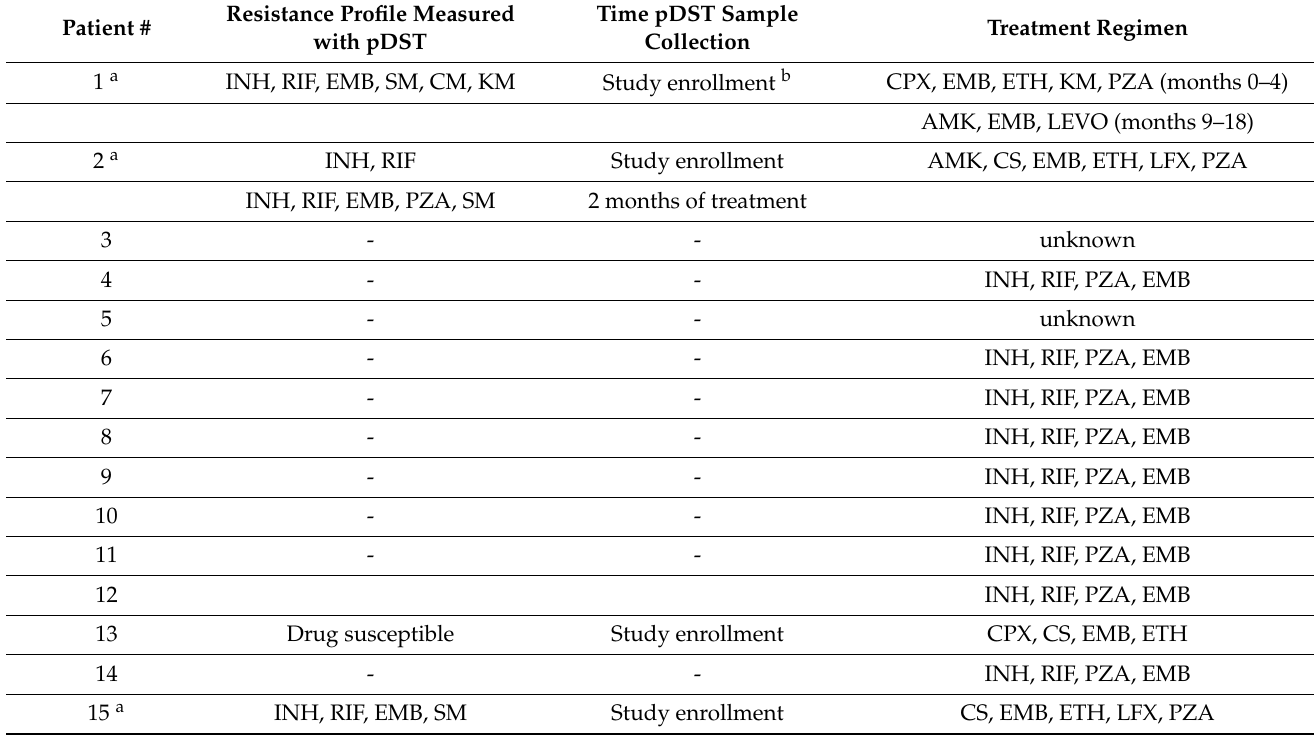
Table 2. Phenotypic DST (pDST)) results and treatment regimens for the 15 patients selected for the study. Patient